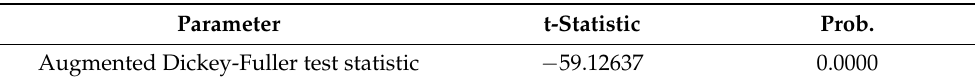
Table 3. Unit Root Test of the Gold Price Returns using ADF Test Statistic.